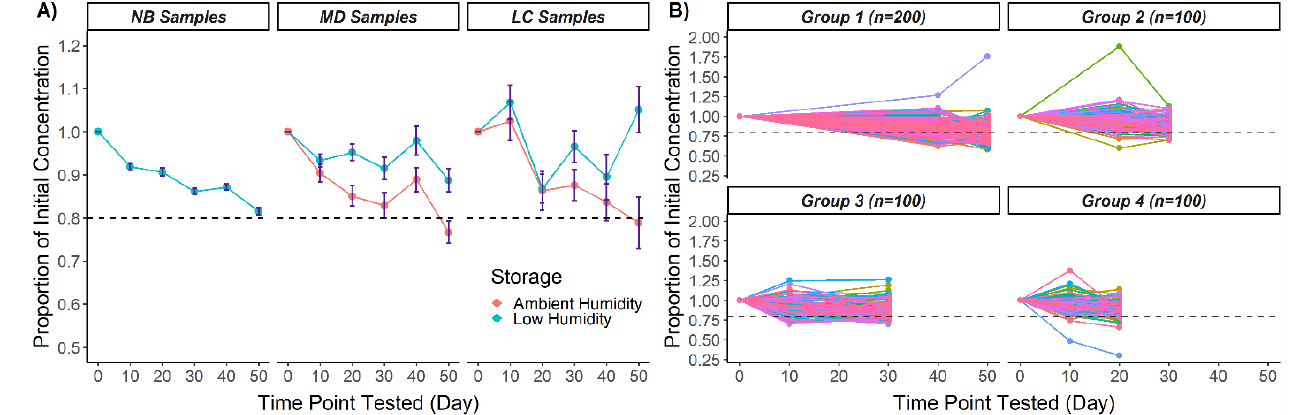
Figure 1. CK ‐ MM recovery over 50 days in ambient and low humidity in three DBS specimen types Figure 1. CK-MM recovery over 50 days in ambient and low humidity in three DBS speci- (NB, MD, LC): ( A ) Mean proportions of initial CK ‐ MM concentrations. Error bars represent ± stand ‐ men types (NB, MD, LC): ( A ) Mean proportions of initial CK-MM concentrations. Error bars ard error of the mean. ( B ) Proportion of CK ‐ MM recovery for individual NB DBS. The 500 NB spec ‐ represent ± standard error of the mean. ( B ) Proportion of CK-MM recovery for individual NB imens were split into four groups after timepoint 0. CK ‐ MM measurements were taken at three DBS. The 500 NB specimens were split into four groups after timepoint 0. CK-MM measurements testing timepoints per group, with individual DBS designated by a line. Two hundred DBS from were taken at three testing timepoints per group, with individual DBS designated by a line. Two one or more groups were tested in low humidity at each testing timepoint past timepoint 0. Dotted hundred DBS from one or more groups were tested in low humidity at each testing timepoint past lines in all panels represent 80% of initial concentration. timepoint 0. Dotted lines in all panels represent 80% of initial concentration.